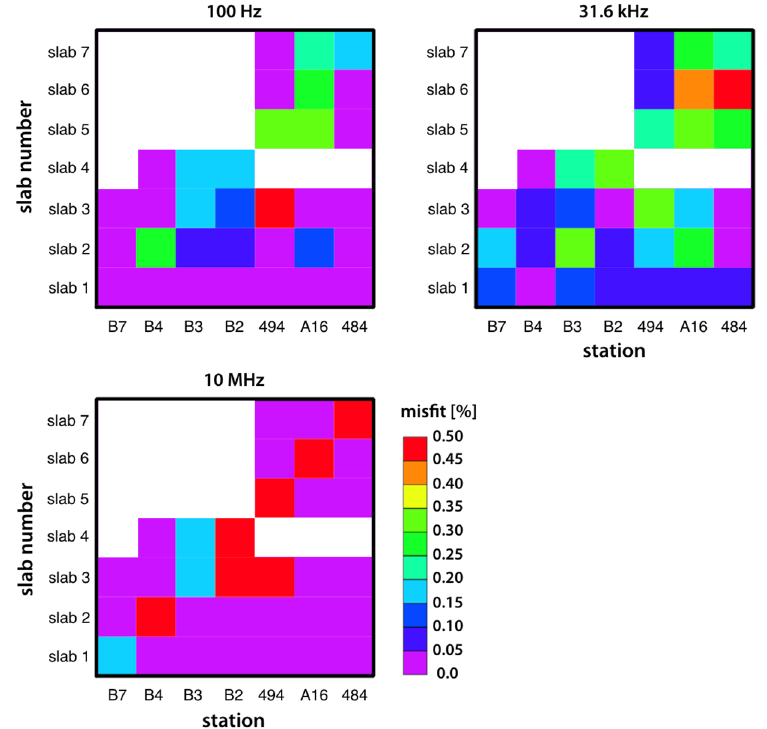
Figure A2. Response misfits for 100 Hz, 31.6 kHz and 10 MHz. Color plot denotes a relative change in percentage misfit for examples of seven soundings after each slab’s resistivity decreases by 5%. The white region in each plot signifies that there is no effect from perturbation to a particular slab detected by that sounding location. The misfits over 0.25% at each frequency are considered significant by rough estimation, and this will affect the 1D, 2D and 3D modelling misfits of transient EM responses in Figure 14.